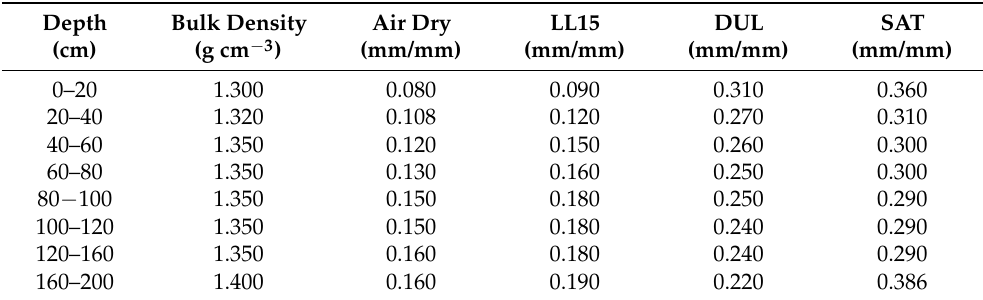
Table 1. The soil hydrological and fertility parameters used in the study